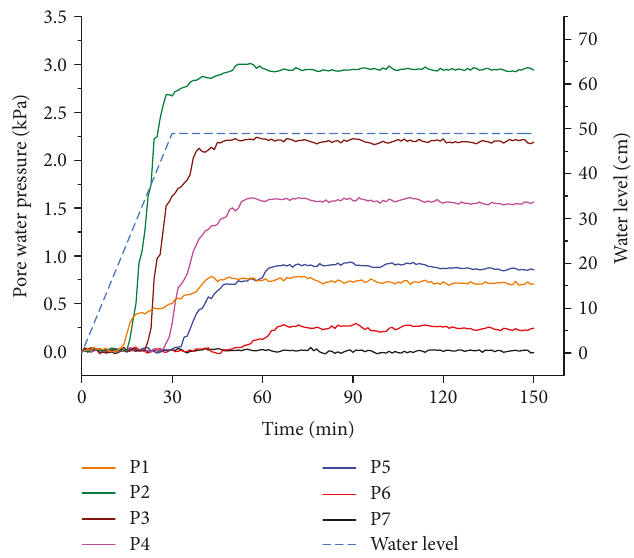
Figure 7: Water level and pore water pressure versus time in the model test.